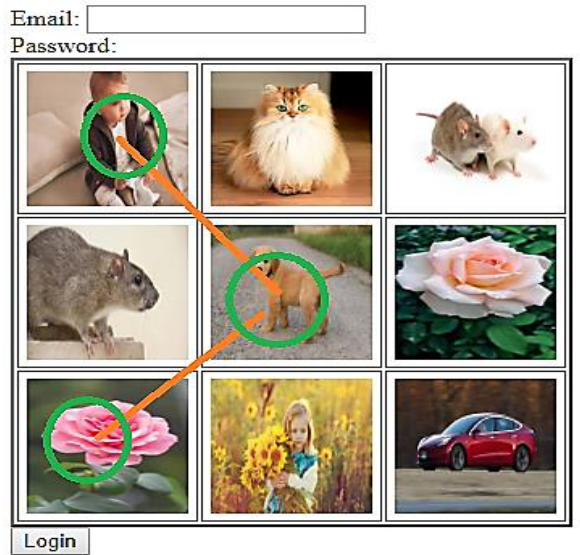
Figure 2. Process of login